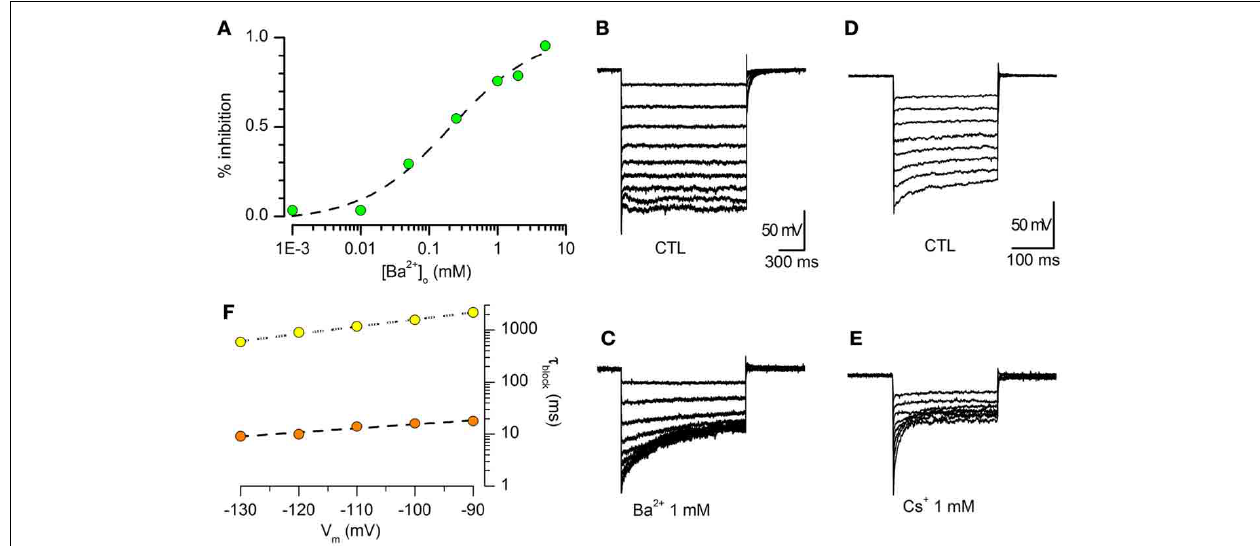
FIGURE 2 | Barium sensitivity. (A) Percentage inhibition of steady-state K ir current vs. [Ba 2 + ]o. [K + ] o = 2.5mM, 32 ◦ C. The data (green dots) were fitted with a logistic function (see text), giving a concentration at half-block (Kd) of 0.21 ± 0.10mM, and a slope (Hill coefficient) of 0.69 ± 0.23 ( n = 5, − 120mV). (B,C) : sample tracings obtained in a single cells in response to